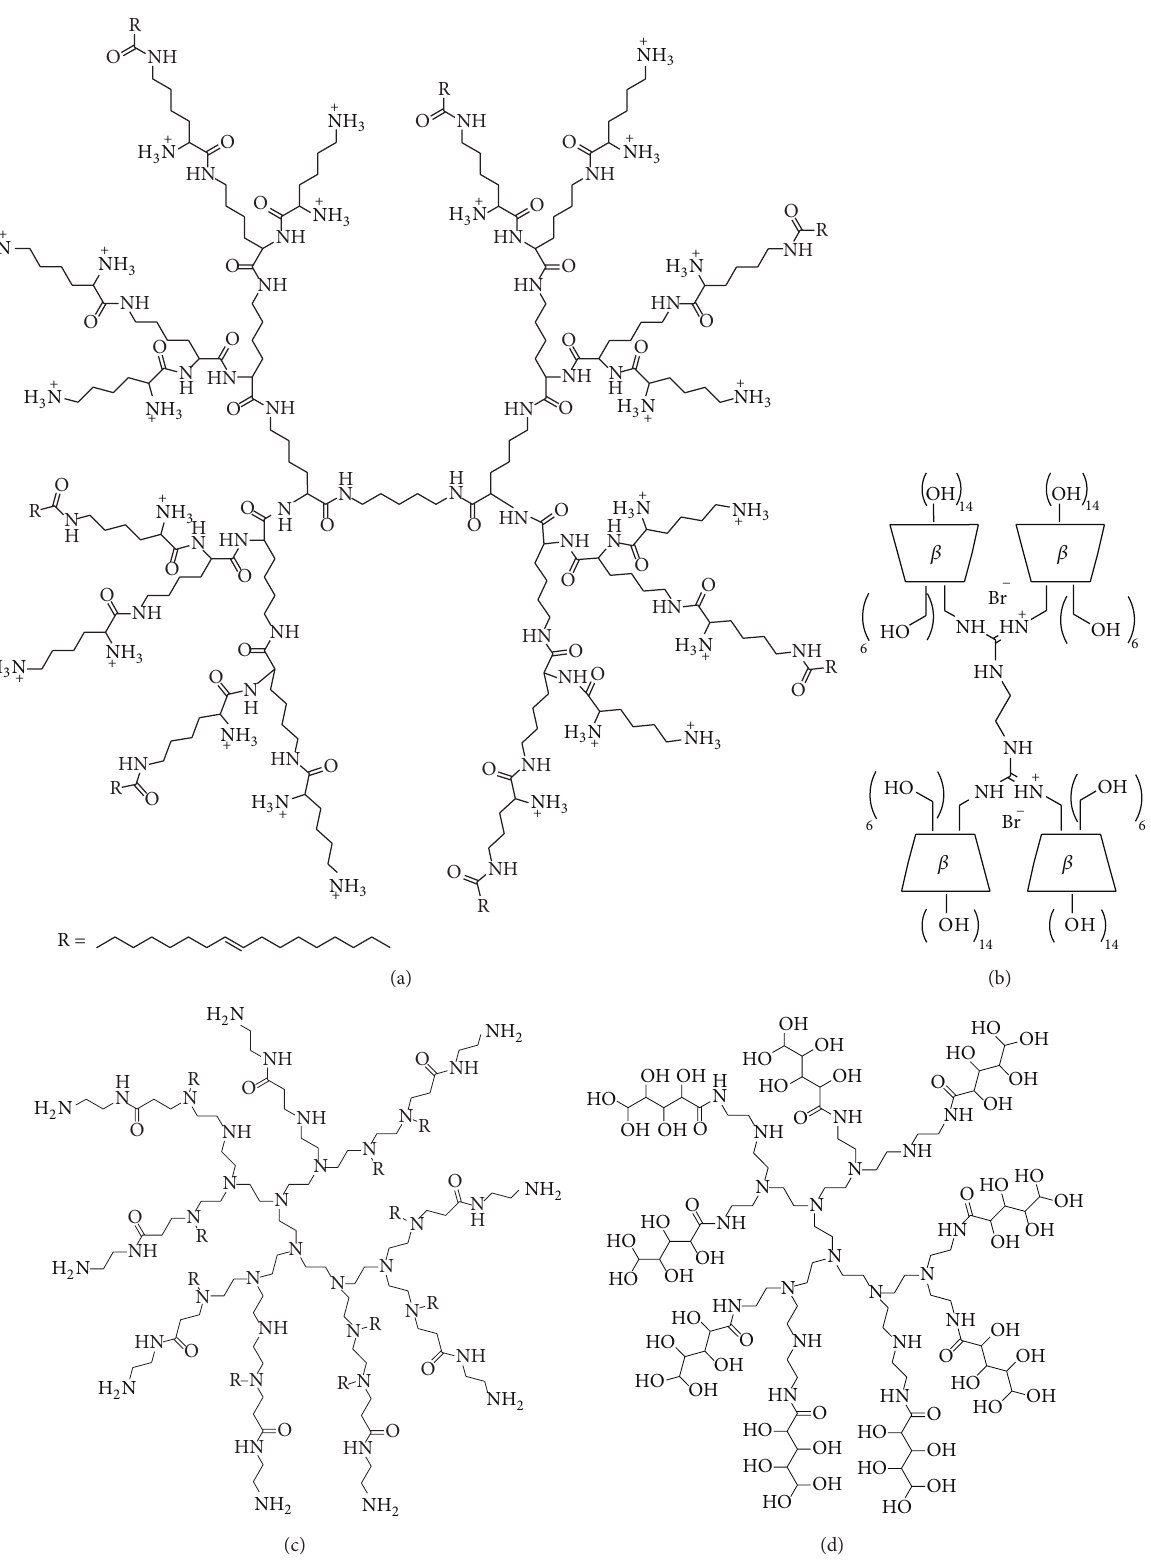
Figure 10: Other types of dendrimers. (a) Dendrimer-lipid component for iNOPs; (b) cyclodextrin tetrapod; (c) PEI-PAMAM; (d)